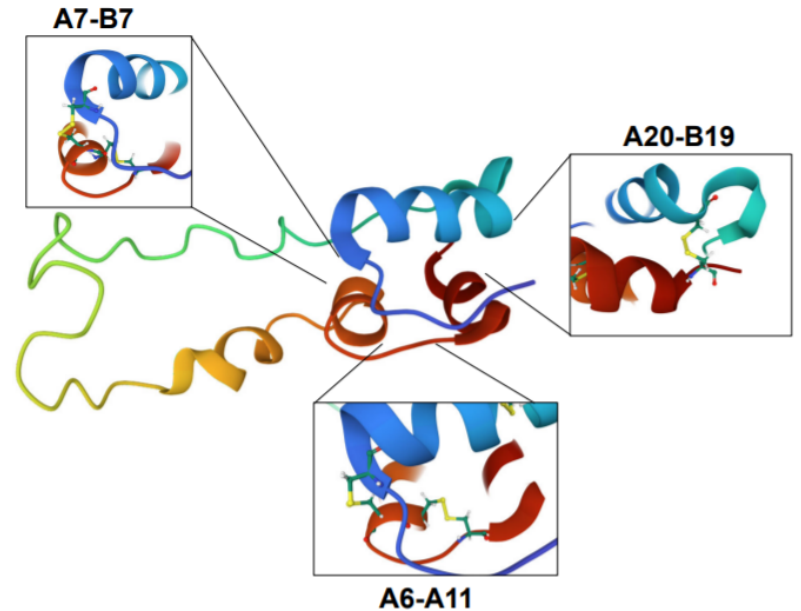
Figure 3. Proinsulin structure. Structure of proinsulin highlighting the disulfide bonds between the A and B chains (A7-B7, A20-B19) and within the A chain (A6-A11), which are necessary for proper folding. Structure is colorized to highlight the following features: blue is the B chain; red is the A chain; green, yellow, and orange denotes C-peptide region. Images were created using Mol* of 2KQP from the RCSB PDB [15,98].